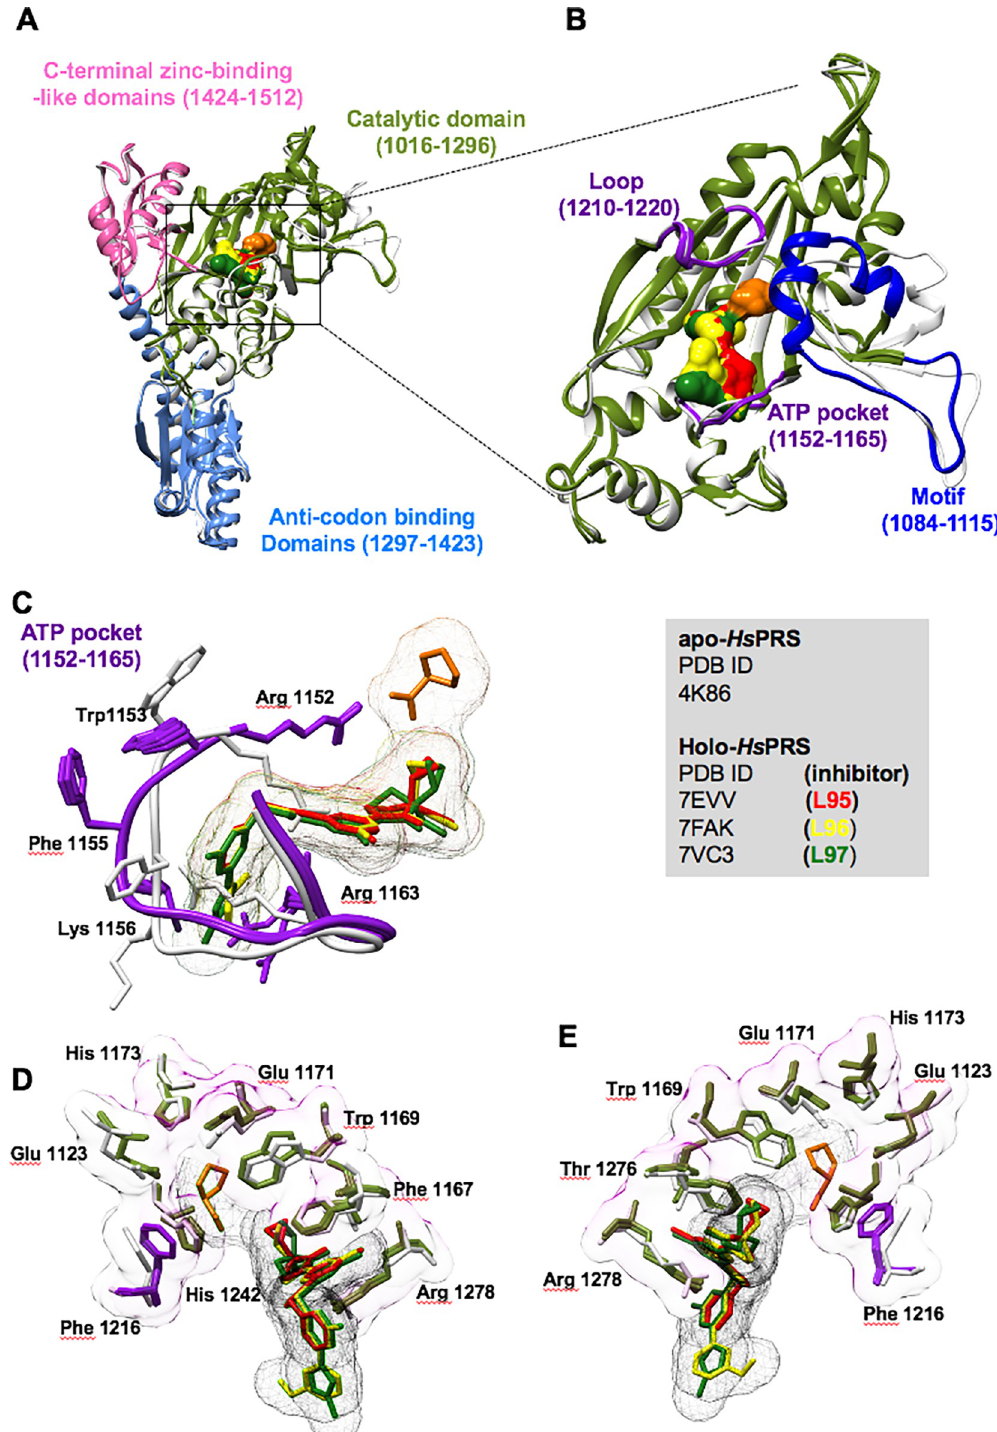
Fig 8. The five inhibitors in complex with Hs PRS. Overall structure of L95-, L96-, L97-bound Hs PRSs. (A) Hs PRS-holo can be divided into three domains. The catalytic domain (1016–1296), anti-codon binding domain (1297–1423), and C-terminal zinc-binding-like domain (1424–1512). (B) The ATP pocket (1152–1165) and the loop (1210–1220) are shown in purple. (C) Structural comparison of the Hs PRS-apo (in grey) and the ATP-mimetics-bound Hs PRS-holo (in purple) is shown. (D and E) The residues forming the cavity compound and the L-pro cavity are shown.